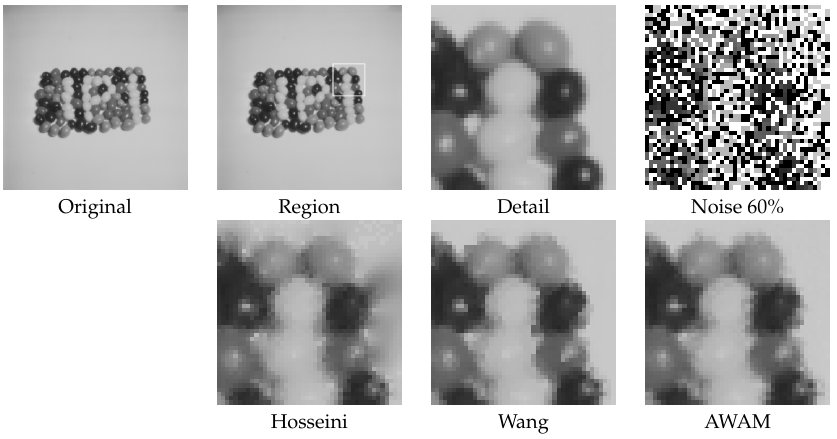
Figure 8. Restoration results of Hosseini, Wang and AWAM filters for the original image 4.1.07.tiff corrupted with 60% salt-and-pepper